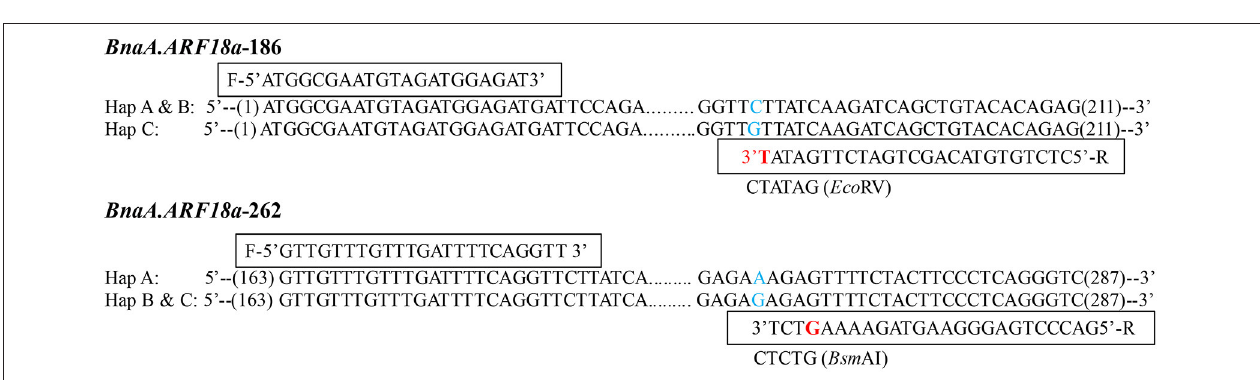
FIGURE 4 | Association mapping and haplotypes of BnaA.ARF18a in natural population of rapeseed. (A) Plot describing marker-trait association for the trait SW (blue dot) and SL (orange dot) within the gene BnaA.ARF18.a . (B) Haploblock showing markers in linkage disequilibrium (LD) ( > r 2 = 0.6). (C) Exon-intron structure of BnaA.ARF18a and single nucleotide polymorphisms. Grey boxes and black lines indicated exon and intron, respectively. (D) Haplotype analysis for BnaA.ARF18.a . in three subgroups. S, W, and SW indicate the spring, winter, and semi-winter rapeseed subgroup, respectively.